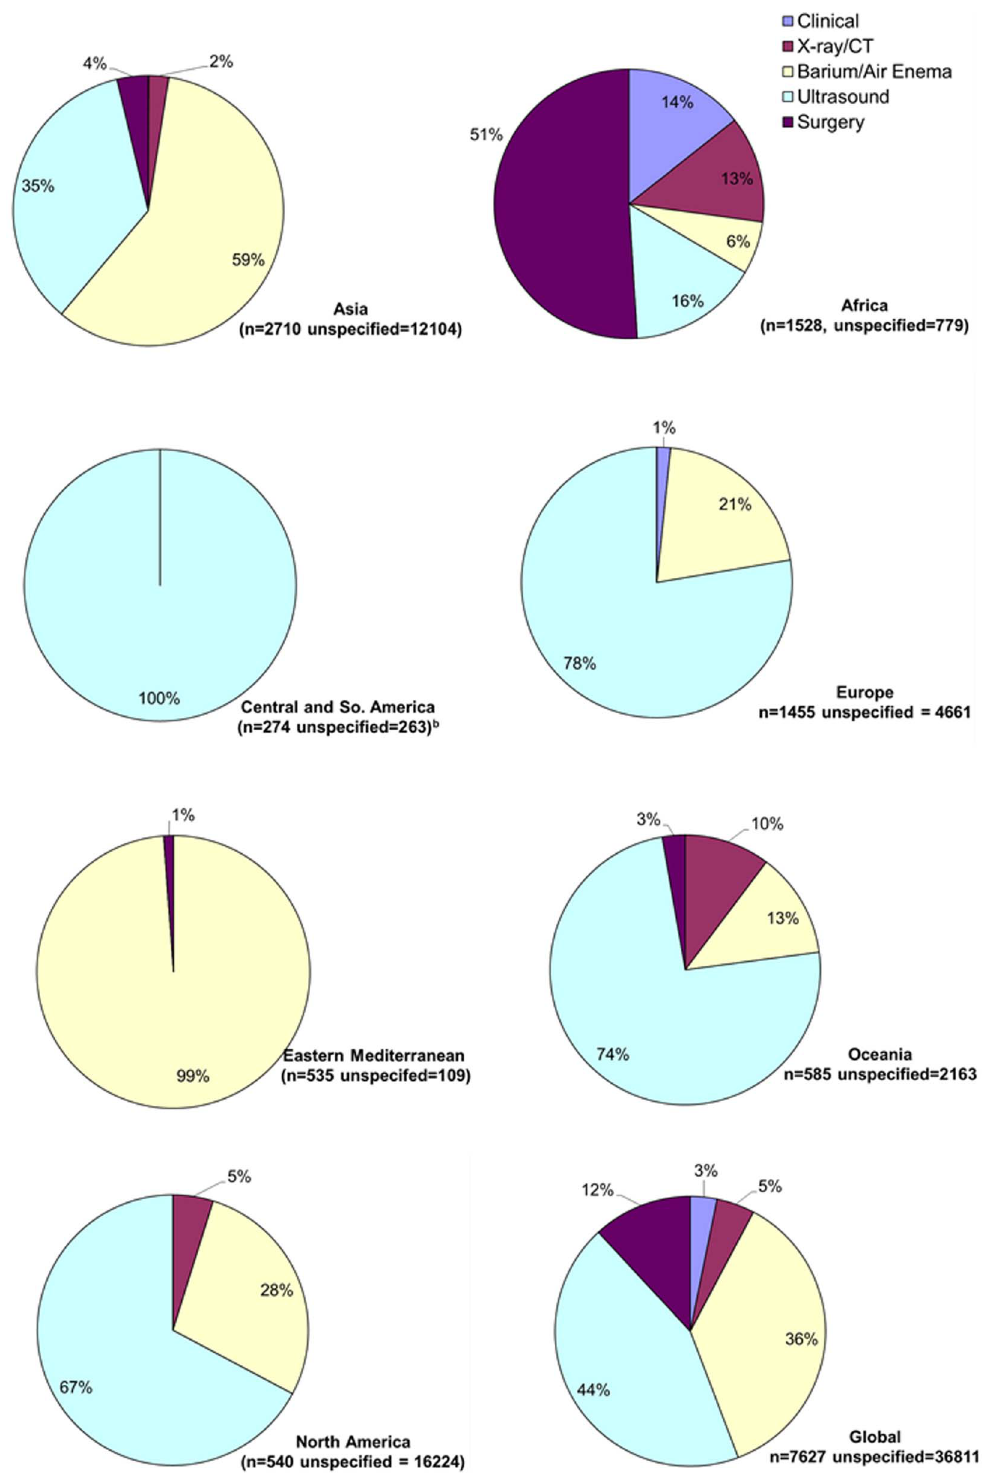
Figure 6. Diagnosis of intussusception by WHO region. Studies where diagnosis was unspecified were not included. Data from Central and South America were from one prospective research study that might not reflect clinical practice under routine conditions. doi:10.1371/journal.pone.0068482.g006 Studies assess the role of wild-type rotavirus infection as a cause absence of any marked seasonal patterns in intussusception, of intussusception have led to conflicting findings with several particularly in settings of Europe, Oceania, and Central and South studies suggesting that a significant association is unlikely [3]. The America where rotavirus disease is quite seasonal supports the